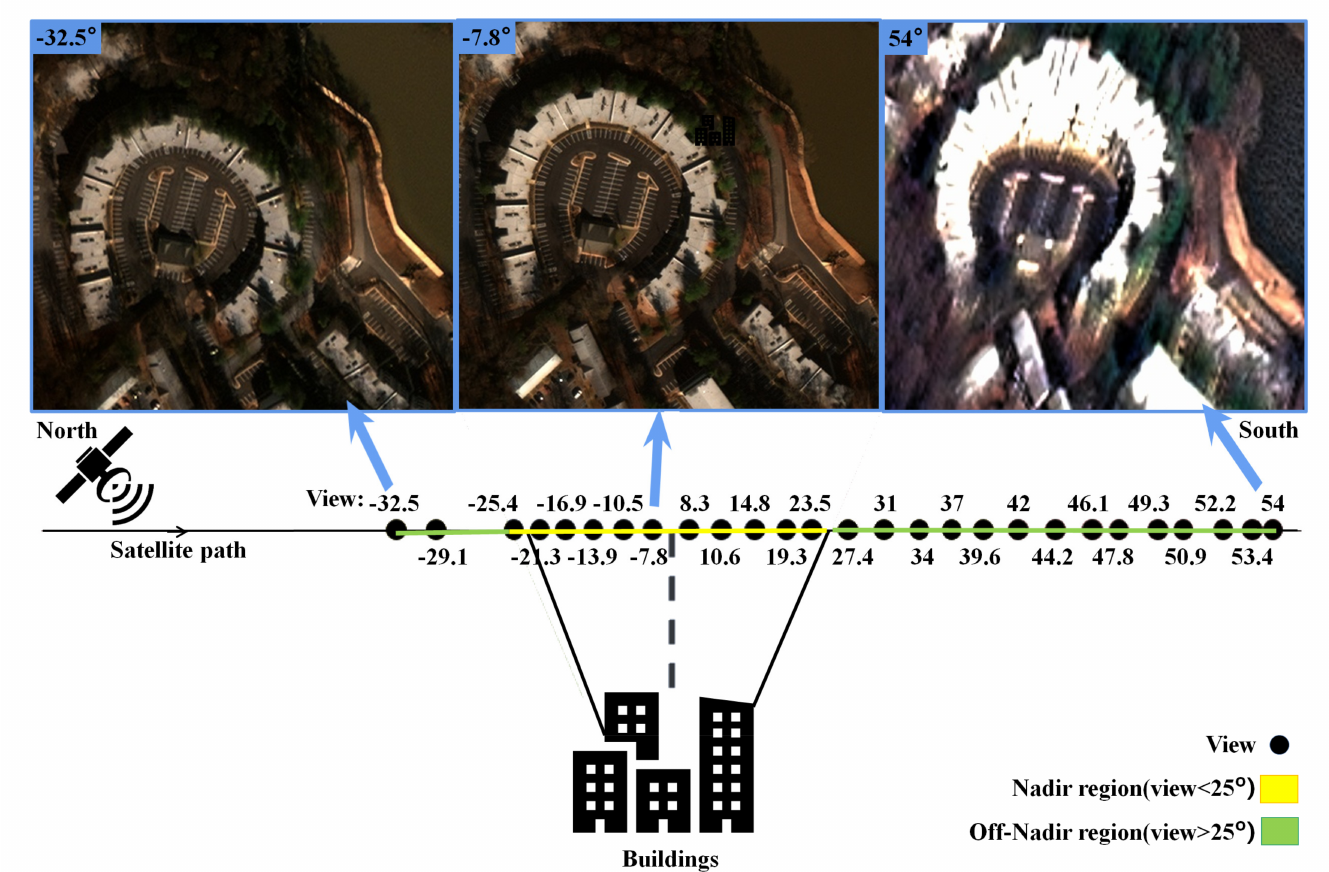
Figure 2. Label inaccuracy on off-nadir images. The upper three images are taken at − 32.5 ◦ , − 7.8 ◦ , and 54 ◦ . There is no ground truth of the off-nadir object, and the direct utilization of the ground truth of the nadir view will impact the detection